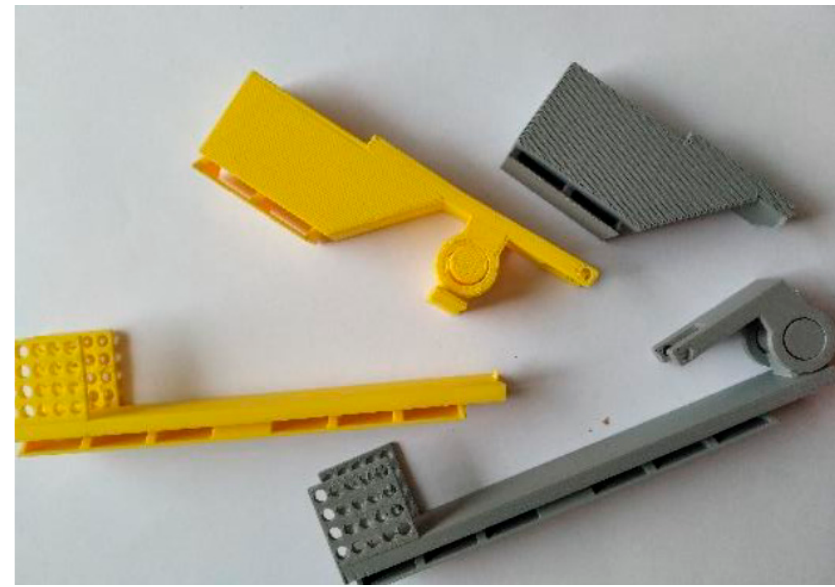
Figure 6. Selected samples (lever) after the test.